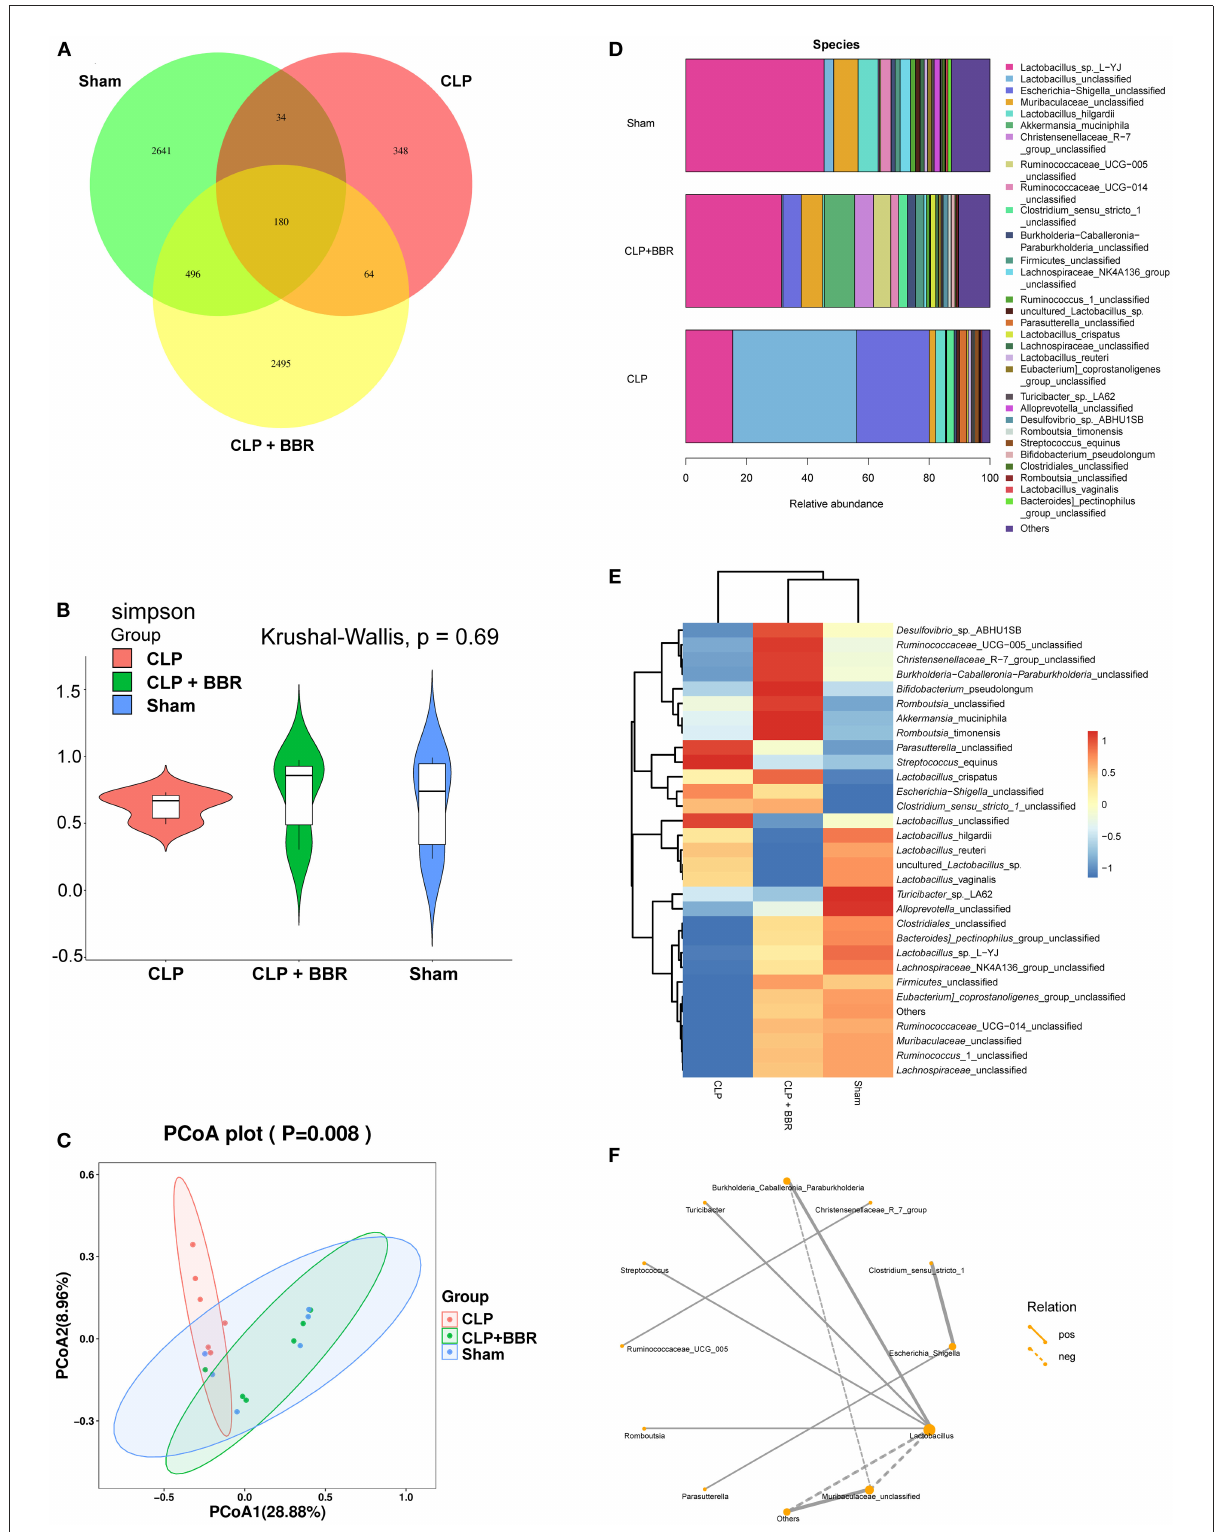
FIGURE4 Berberine improved the gut microbiota homeostasis in CLP rats. (A) The venn of feature expression abundances. (B) The ameliorative effect of berberine on the gut microbial species richness was analyzed by the Simpson index of alpha diversity analysis. (C) The principal